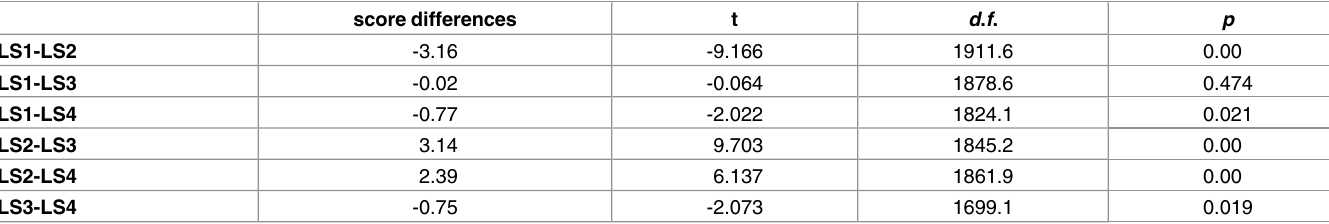
Table 1. T-tests for leadership